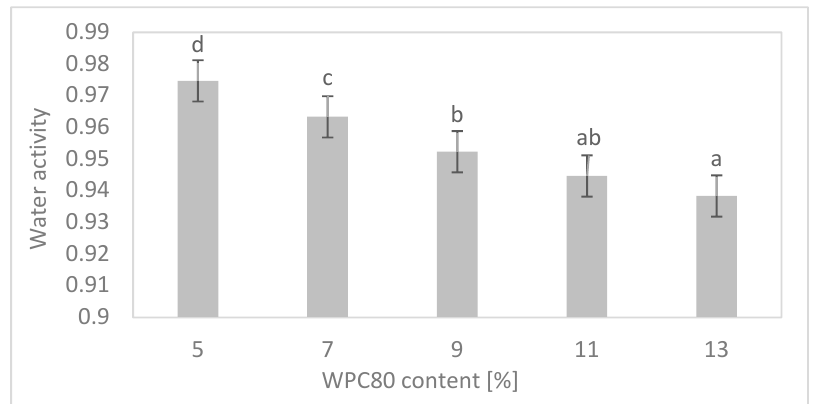
Figure 3. Effect of different WPC80 contents on water activity of high-protein fat-free dairy desserts. Letters (a–d) indicate significant differences at p < 0.05 (Tukey’s HSD test).